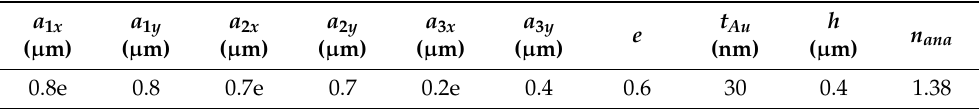
Table 3. Initial geometrical parameters of the designed SPR-PCF.